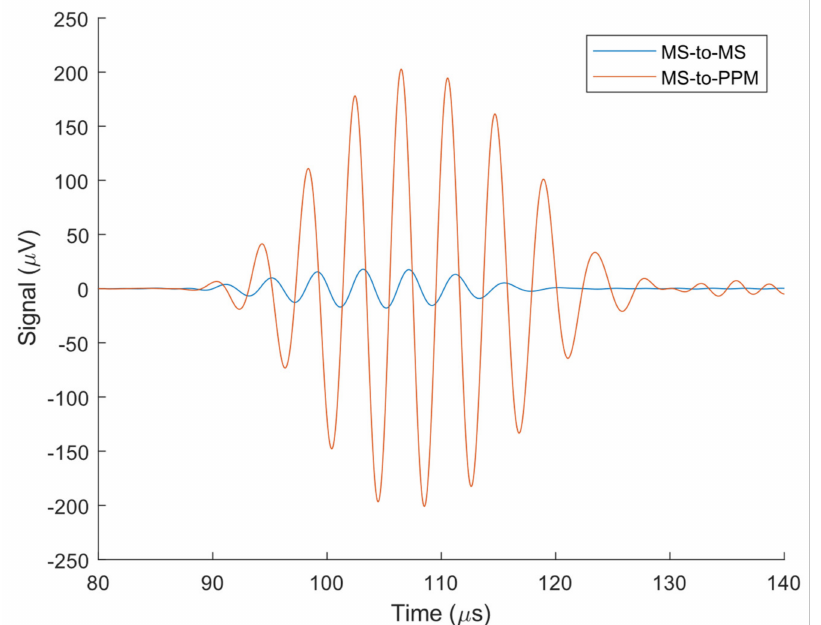
Figure 11. Experimental MS-to-MS and MS-to-PPM Receiver Voltage on Steel Plate. Both MS-EMAT transmitter and receiver have a magnet liftoff of 8.92 mm. The input current to the transmitter in both tests is the same waveform with a maximum of 35.1